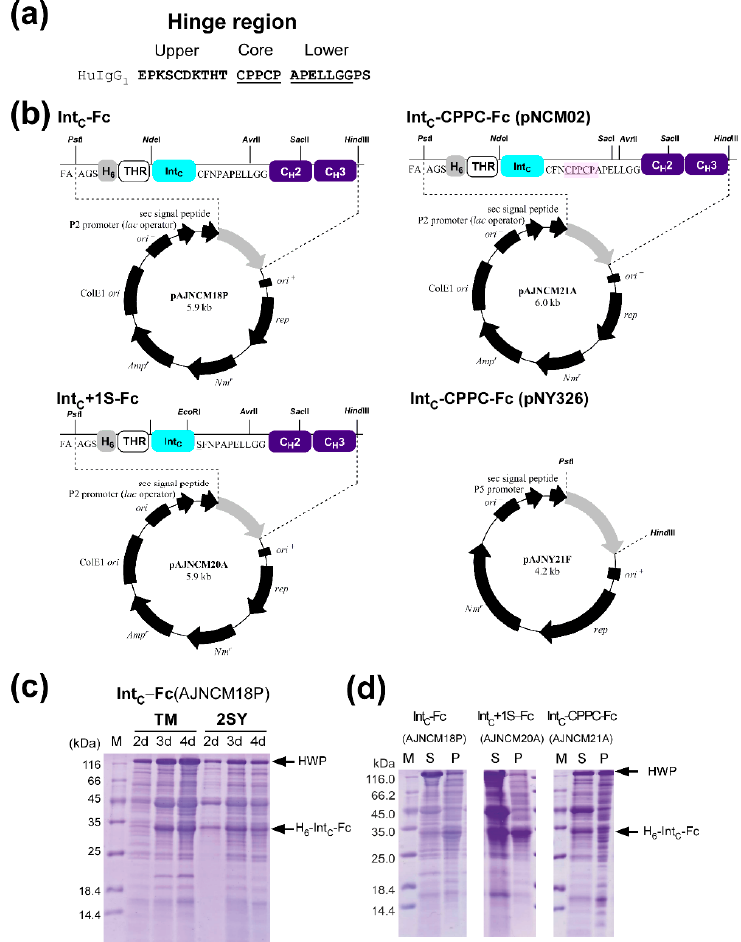
Figure 4. Vector designs and protein production of Int C -Fc. ( a ) Primary structure of the hinge region of human IgG. ( b ) Vector maps of three constructs (Int C -Fc, Int C +1S-Fc, and Int C -CPPC-Fc) in the backbone of pNCM02 and pNY326 vector. ( c ) Optimization of the growth media. Production of Int C - Fc was compared in TM and SY media. Lanes 2d, 3d, 4d indicate SDS-PAGE analysis of the culture supernatant after 2 days, 3 days, and 4 days of protein expression, respectively. ( d ) Comparison of protein production between Int C -Fc, Int C +1S-Fc, and Int C -CPPC-Fc by SDS-PAGE analysis. Lanes S and P indicate supernatant and pellet fractions from the culture medium after four days of protein expression, respectively. The control cell wall protein (HWP) and Int C -Fc are marked with arrows.